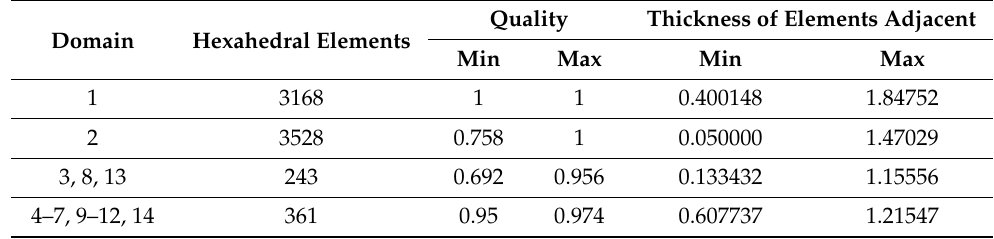
Figure 2. Mesh with details used during numerical calculations. Images used courtesy of ANSYS, Inc. Table 1. Mesh quality in domains.